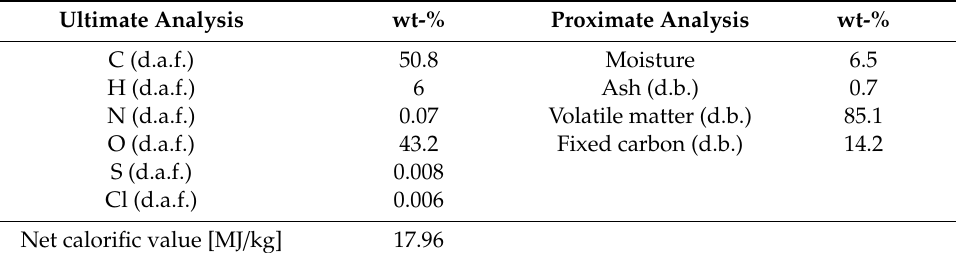
Table 1. Summary of the Ultimate and Proximate analysis for industrial wood pellets.